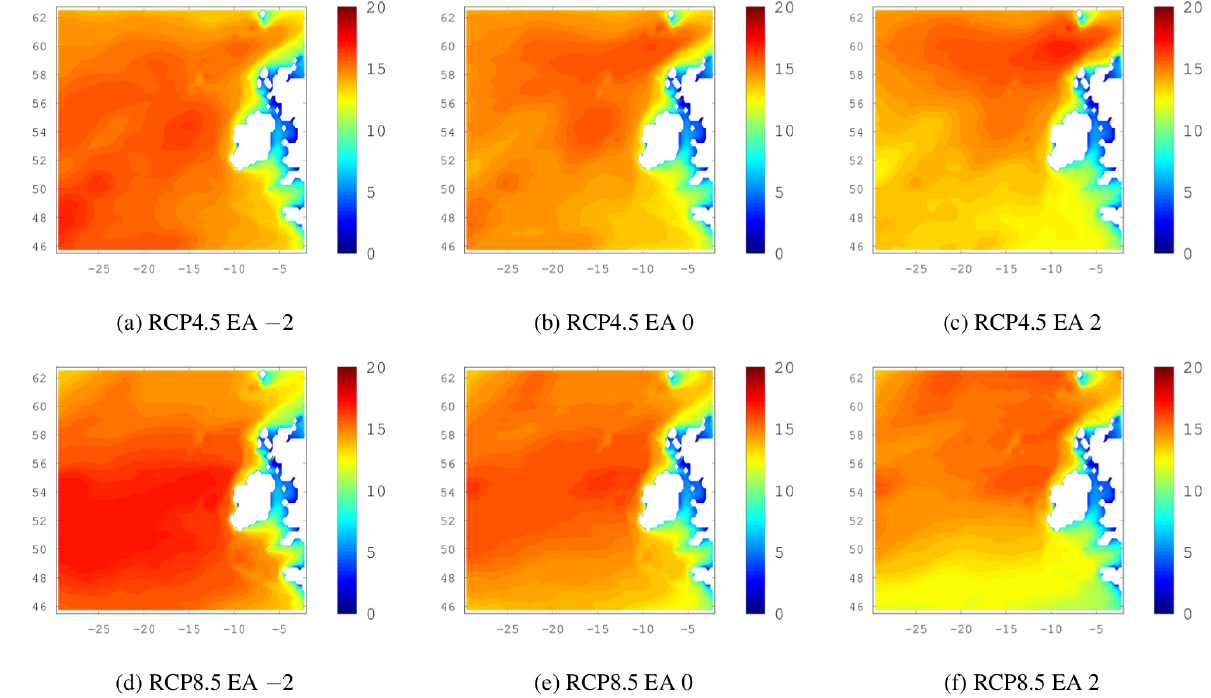
Figure C2. 20-year return levels of H s . The EA index varies from 3 values of the NAO index while the NAO and SCAND are held in their neutral state (zero). The top row shows the ensemble mean for the future period under RCP4.5 and the bottom row is similar but shows RCP8.5